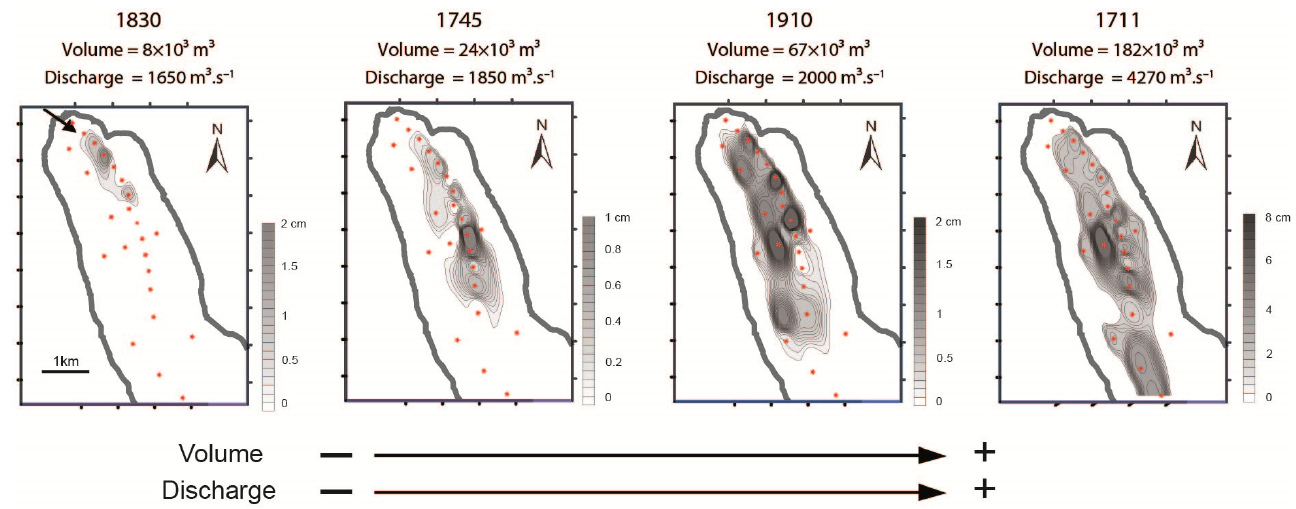
Figure 9. Flood-sediment volumes reconstructed from a multi-coring approach and calibrated with a long gauge series enabled reconstructing flood discharges of the upper part of the Rhône River (European Alps) over the last 350 years from the sediment sequence of Lake Bourget (modified after Jenny et al., 2014 [54]). Red points indicate core locations.